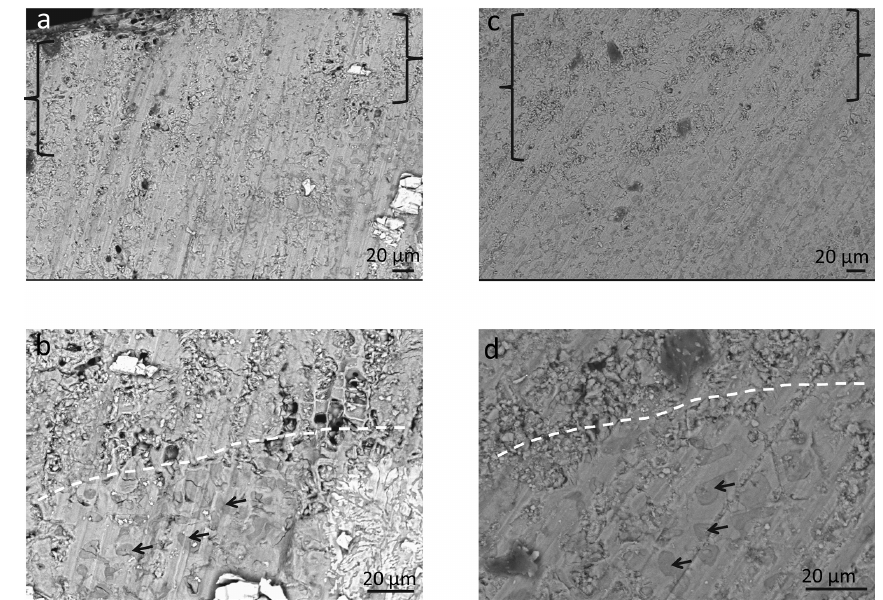
Figure 6. Transition from pre-experimental crust to experimental crust in P. onkodes , pre-industrial CCA (a, b) (BSE), high CO 2 CCA (c, d) . Transition from pre-experimental growth to experimental identified by following the growth lines from the crust on the resin (not pictured) across the sample. (a) Overview, brackets- new growth. (b) Close up of transition. Crust below dashed line is pre-experimental growth. Dolomite infills cells (black arrows). Above dashed line new growth does not have cells infilled, crust has been damaged by saw cut. (c) Overview of transition to new growth in high CO 2 CCA, brackets – new growth. (d) Close up of transition. Similarly to control and pre-industrial CCA, cells in pre-experimental growth are infilled with dolomite (black arrows). Crust above dashed line grew during experiment. Cells are not infilled with dolomite and crust has crushed in S3 under the sawcut. Scale bars (a, b, c) and (d) = 20 microns. Close up of transition from pre-experimental growth to experimental growth in supplement Fig.